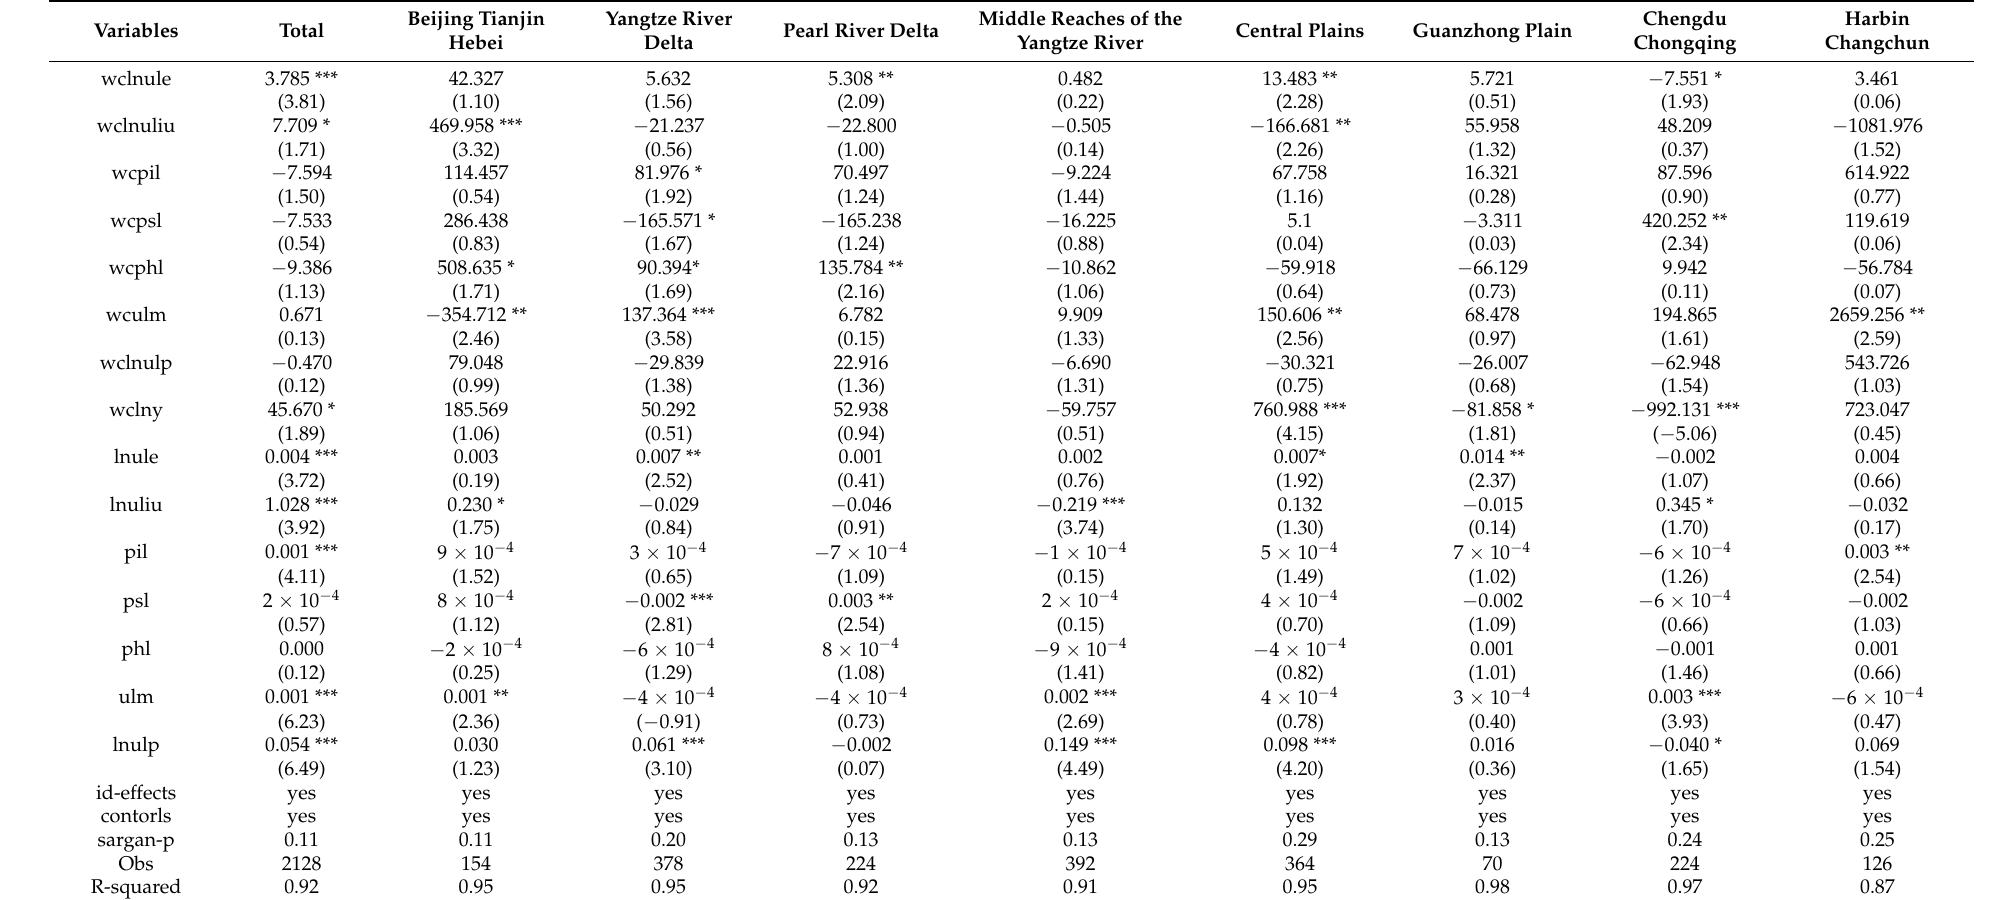
Table 3. Regression estimate results for impacts of ULUT on